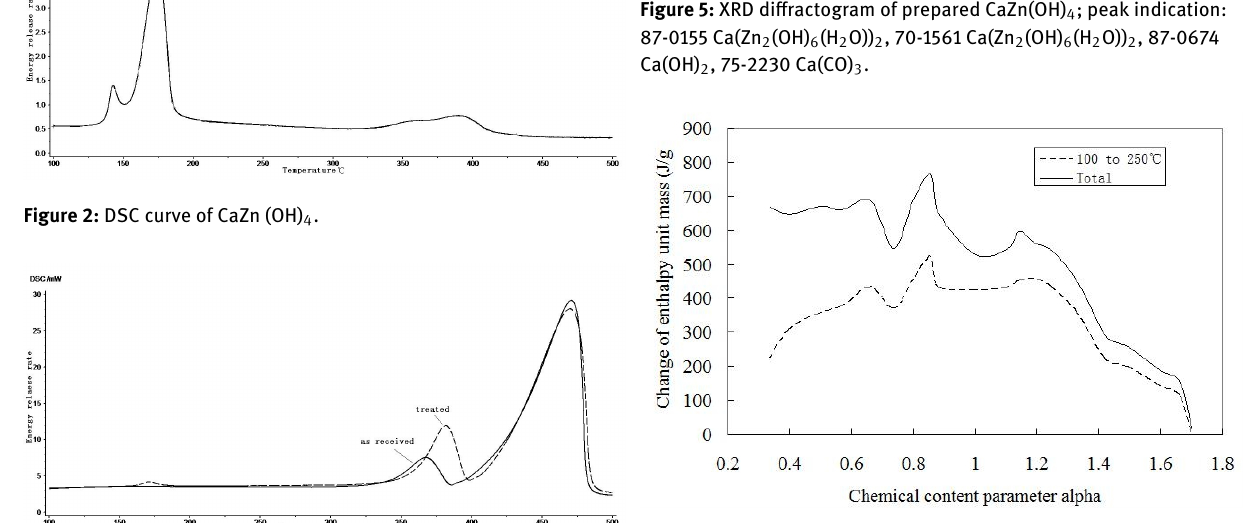
Figure 3: DSC curves of as received and treated Ca(OH) 2 .